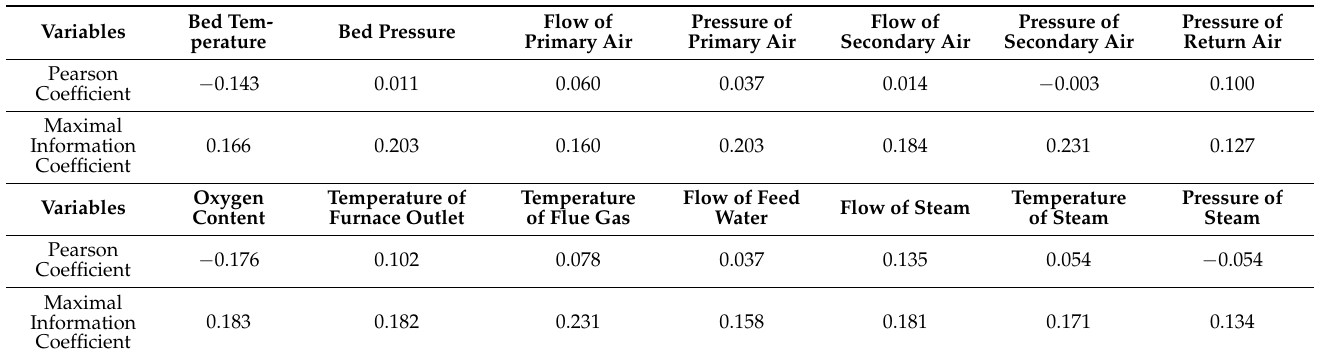
Table 2. Correlation between PCDD/F emissions and operational